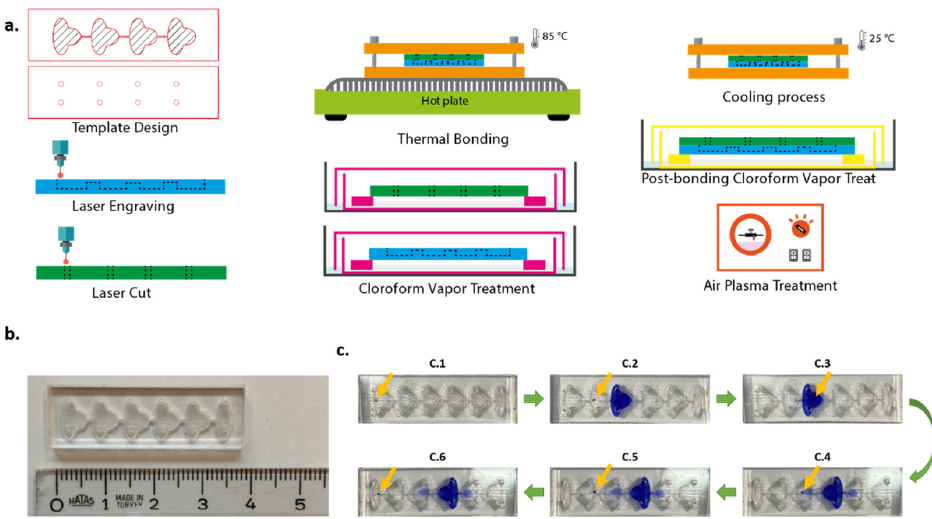
Figure 1. Chip fabrication procedure ( a ), upside view of the six-compartment chip ( b ). Staining procedure of magnetic bead-cell conjugates in the chip ( c ): (C.1–C.6) captured with mobile phone camera. Yellow arrows show the position of the cell–magnetic bead conjugates.